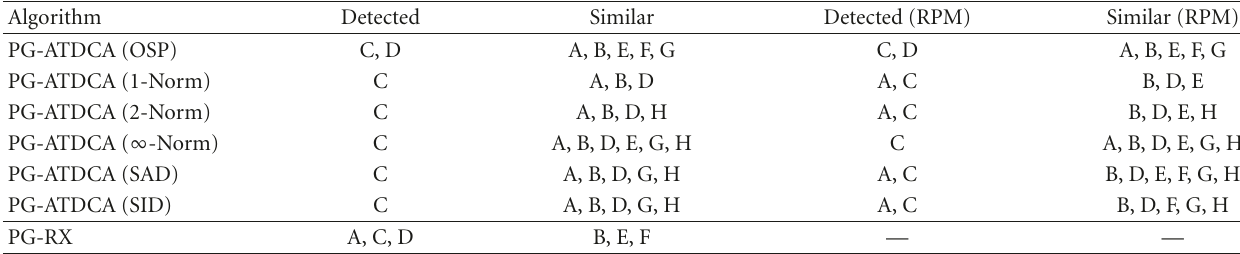
Table 4: Summary of detection results achieved by the PG-ATDCA and PG-RX, with and without the RPM strategy.